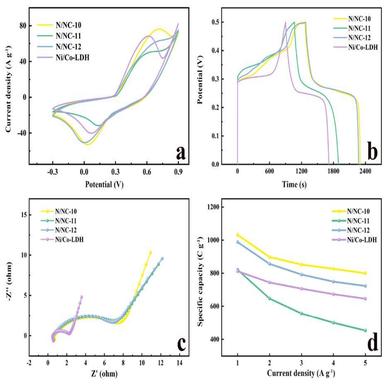
The electrochemical properties of N/NC-10, N/NC-11, N/NC-12 and Ni/Co-LDH. CV curves at 30 mV s − 1 (a), GCD curves at 1 A g− 1 (b), the Nyquist plots of impedance data (c) and specific capacity at various current densities from 1 A g− 1 to 5 A g− 1 (d).